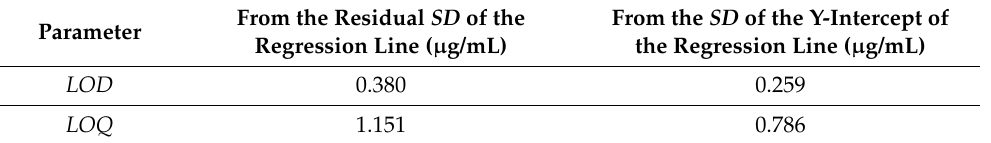
Table 1. LOD and LOD for sensitivity analysis. From the Residual SD of the Parameter Regression Line ( µ g/mL)